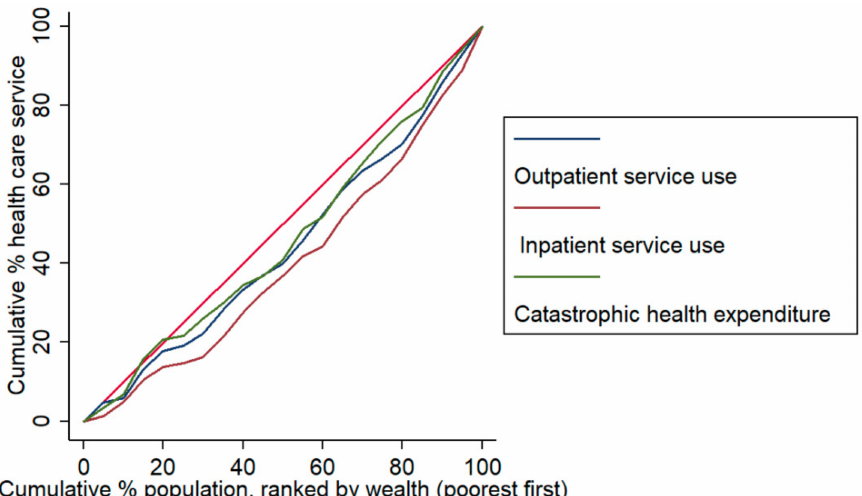
Figure 2. Concentration curves of health service use and expenditure for patients with cancer in China in